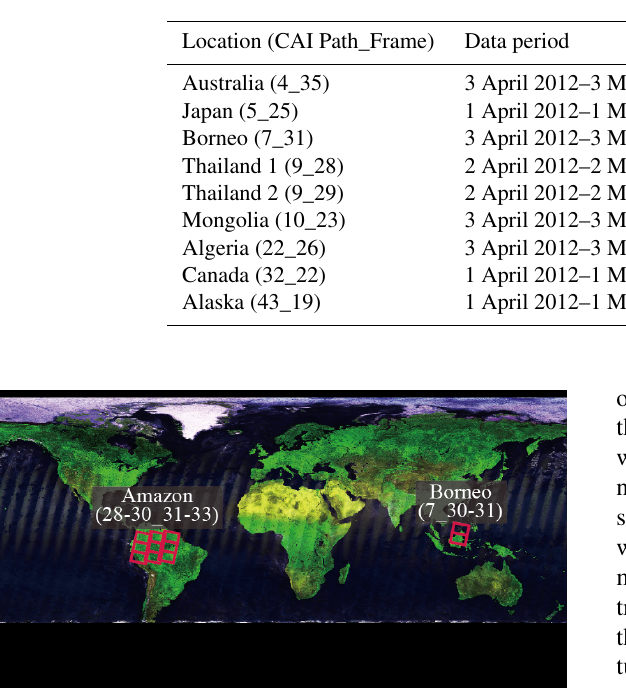
Table 2. GOSAT CAI L1B product and CAI L2 cloud flag product used for various land cover types in this study. Land cover was derived from the MODIS land cover type product (MCD12). Japan scenes include urban areas.